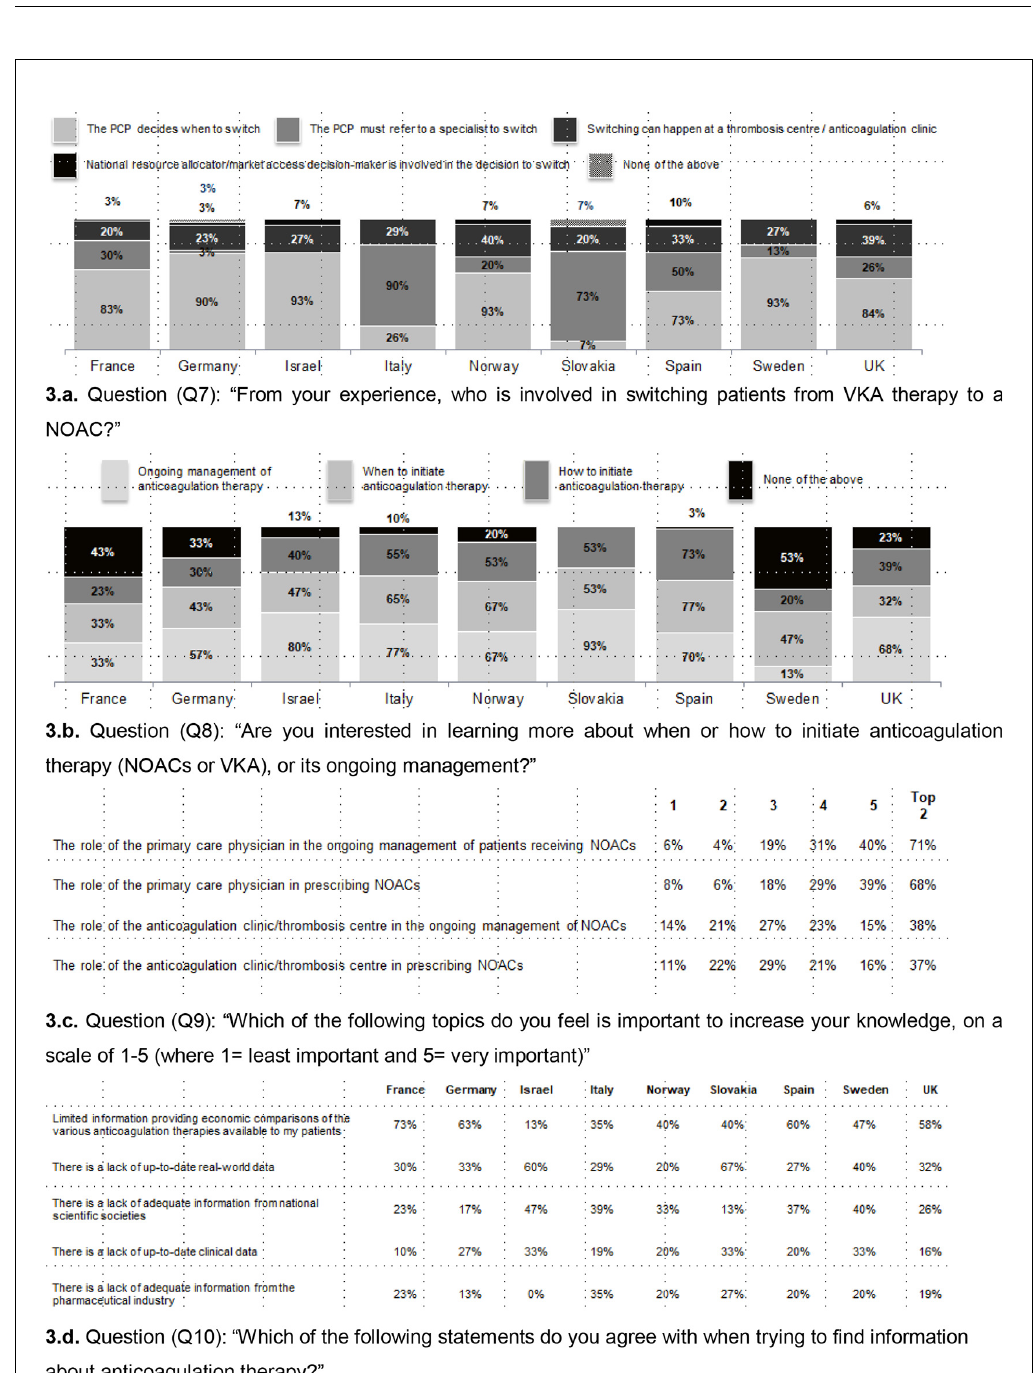
Figure 3. Perceived information needs NOAC = non-VKA oral anticoagulant. PCP = primary care physician. VKA = vitamin K